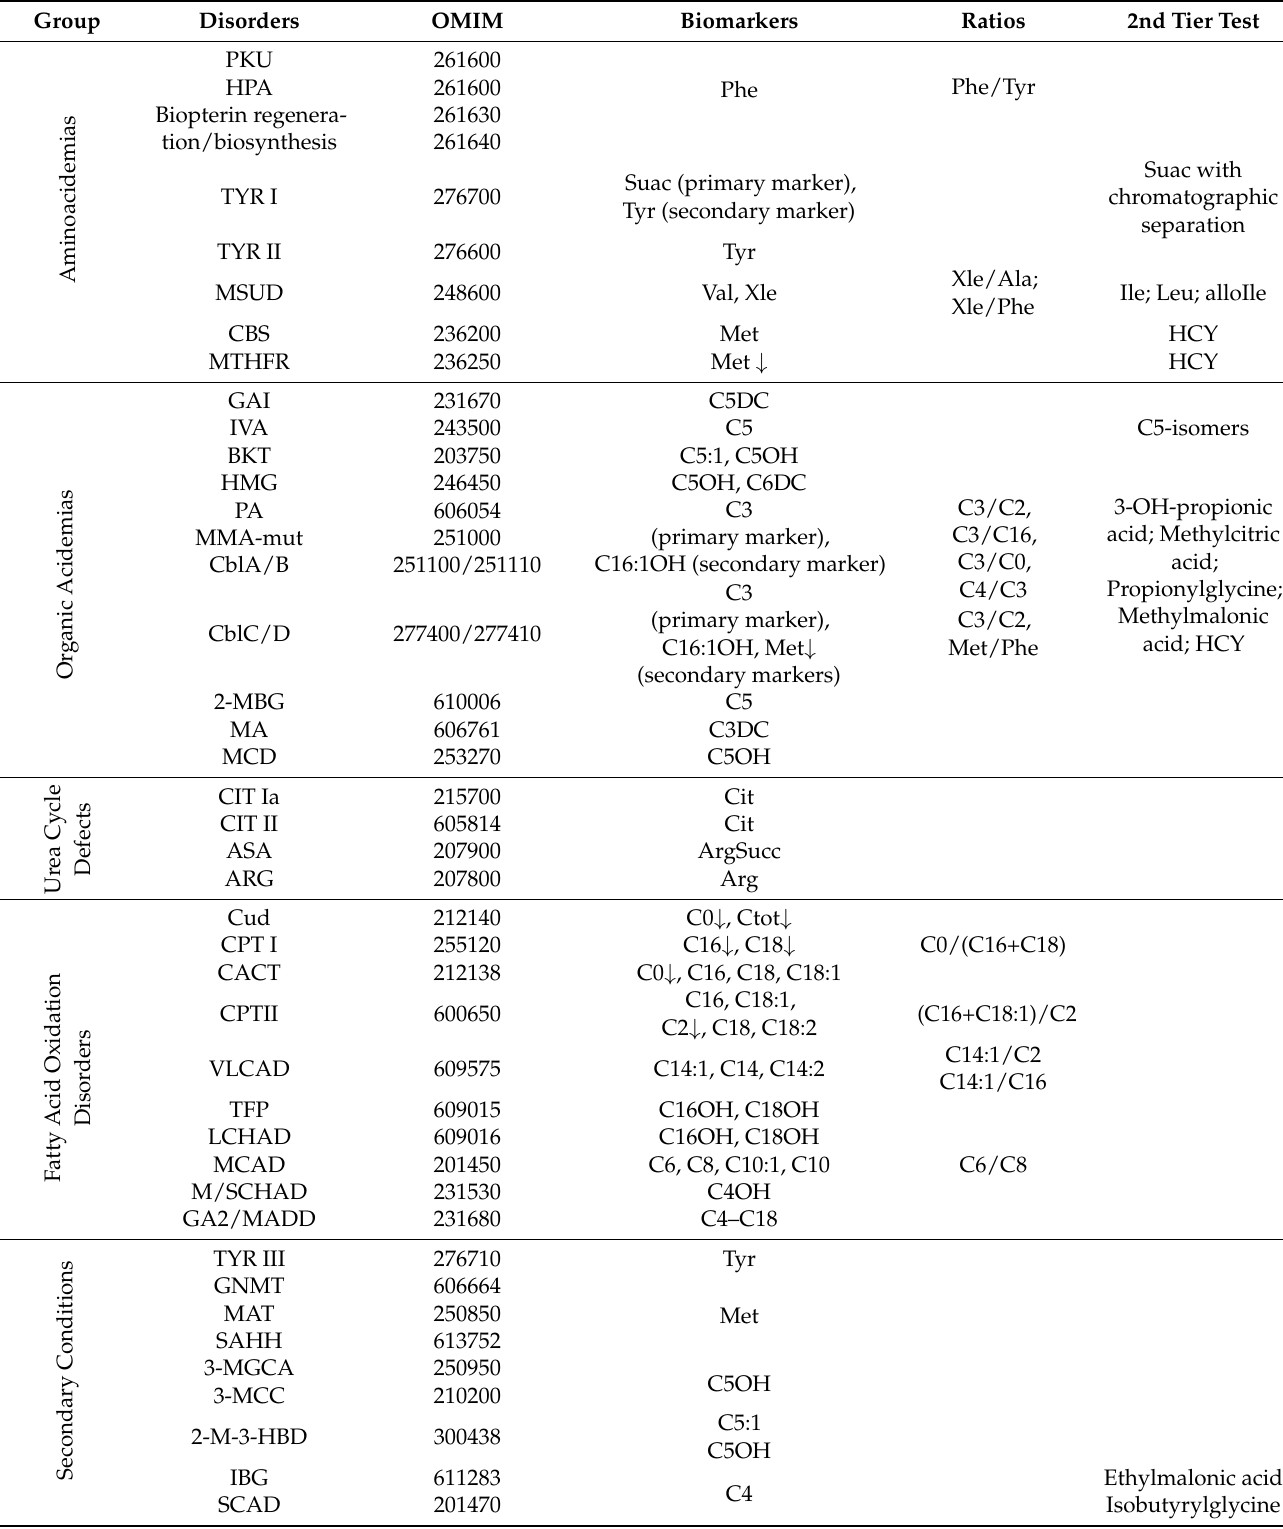
Table 1. Disorders currently screened by MS/MS-based newborn screening in